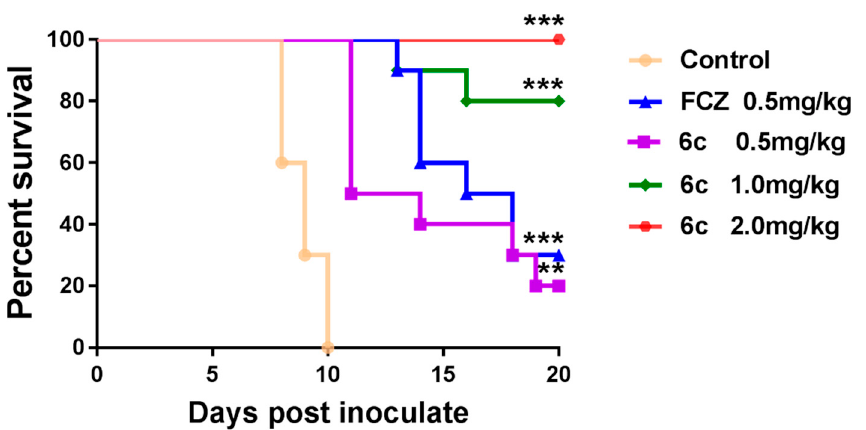
Figure 6. In vivo efficacy of compound 6c (0.5, 1.0 and 2.0 mg/kg) and FCZ (fluconazole, 0.5 mg/kg) in a systemic infection of an ICR mouse model ( n = 10) with C. albicans SC5314. ** p < 0.01, *** p < 0.001, determined by